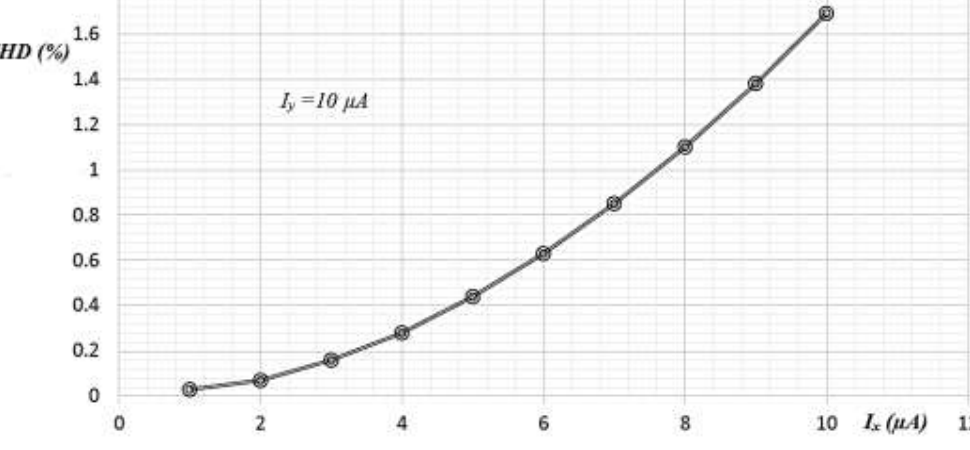
Figure 7. THD(%) variation versus